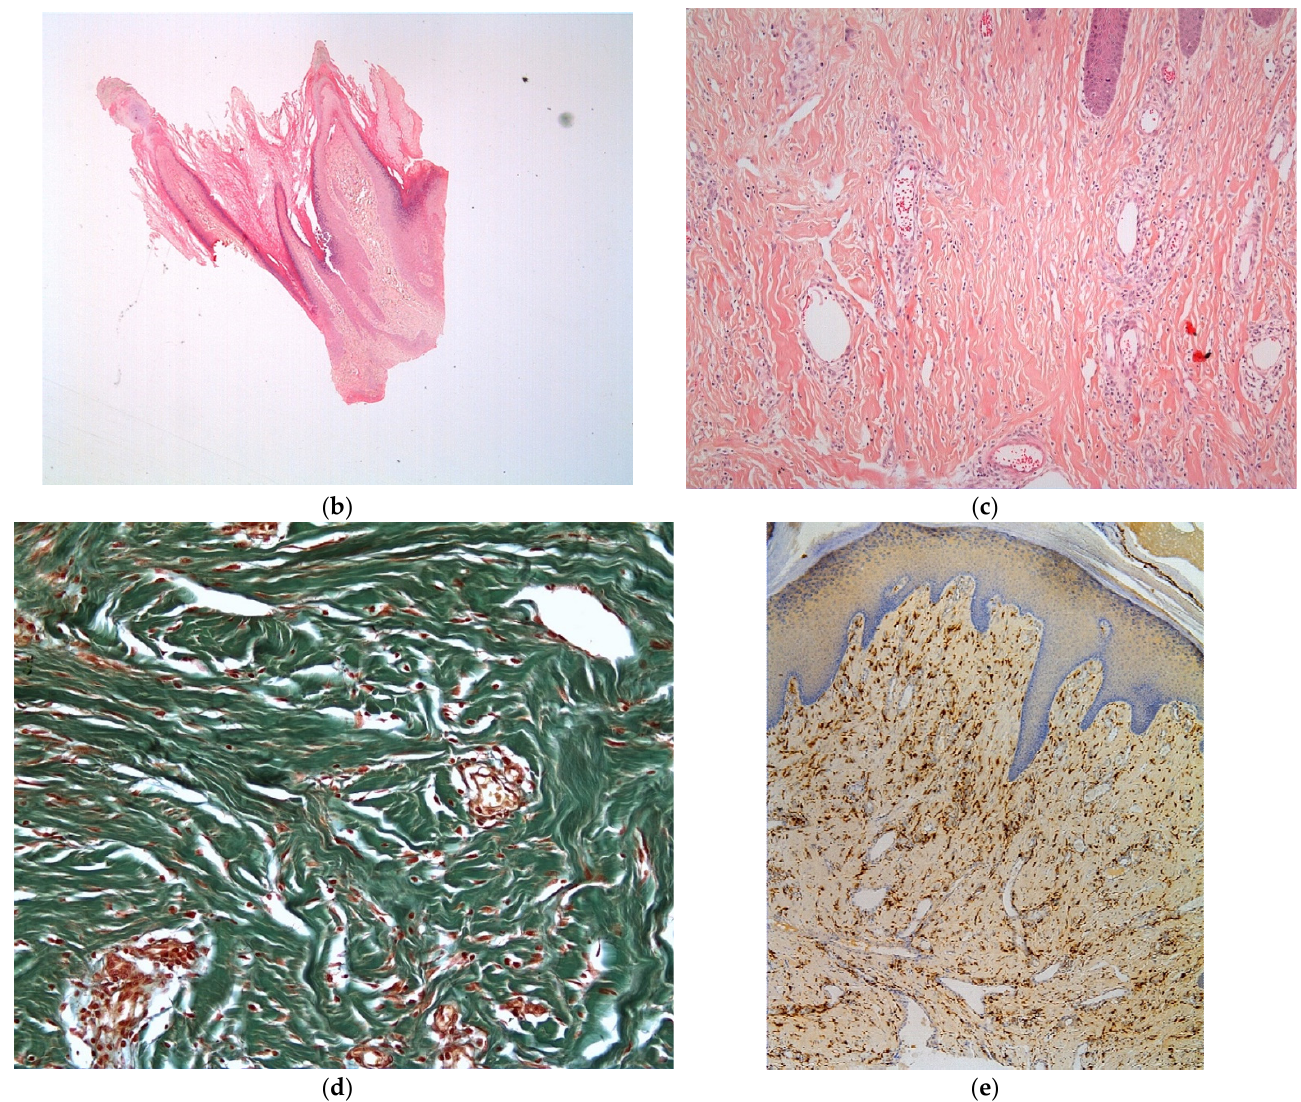
Figure 3. Periungual fibroma. ( a ). Clinical aspect of a toe periungual fibroma; ( b ). Hematein eosin ×5: exophytic dome- shaped lesion with hyperplastic epidermis; ( c ). Hematein eosin ×20: collagen bundles are vertically oriented; increased number of dilated venules; ( d ). Orcein staining × 40: decreased elastic fibers; ( e ). Immuno-histochemistry with anti-FXIIIa antibody showing positivity of stellate cells.